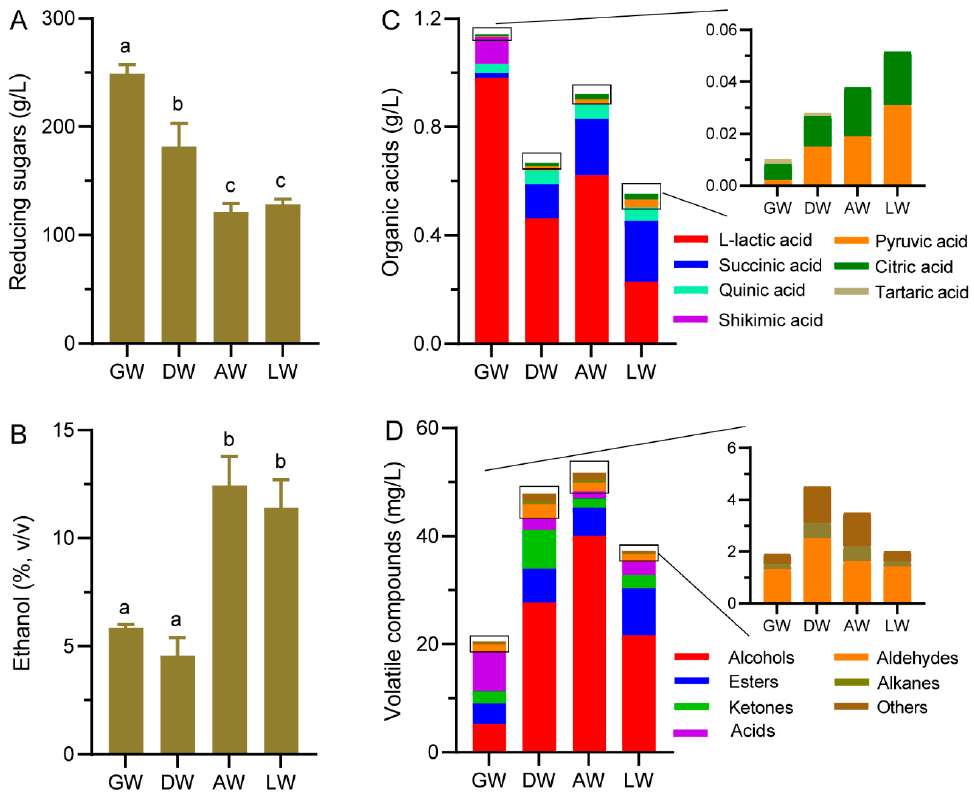
Figure 4. The chemical indexes of rice wine fermented by different Qu. ( A ) Reducing sugars, ( B ) ethanol, ( C ) organic acids, ( D ) volatile compounds. Bars with different superscript letters within a figure indicate significantly different ( p < 0.05). Results are shown as the mean from three biological replicates.